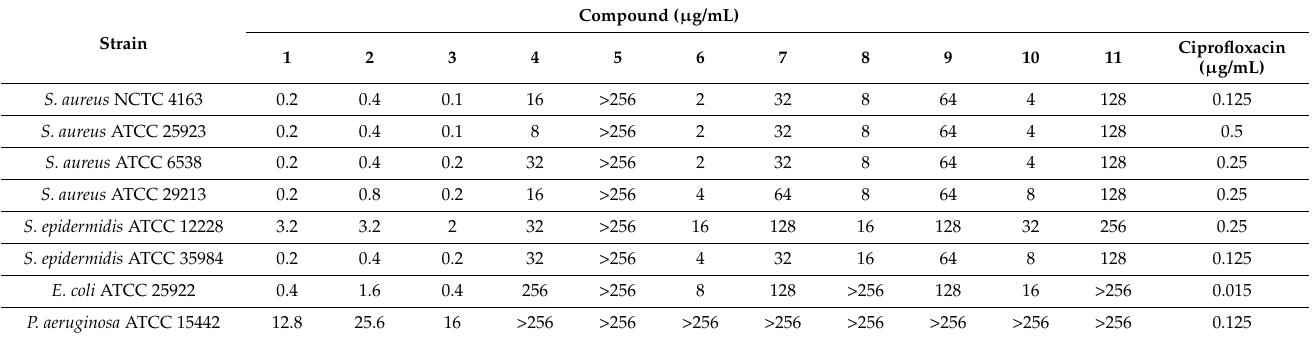
Table 3. Activity of compounds against standard bacteria strains, expressed by minimal inhibitory concentrations ( µ g/mL).